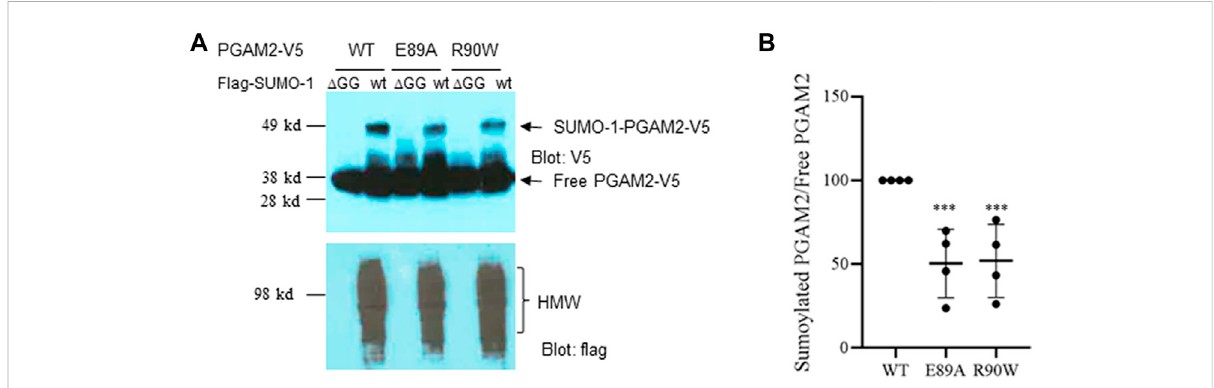
FIGURE 8 PGAM2 withmissensemutations linked with human disease exhibit reduced sumoylation.A Ni-NTApulldownexperiments wereperformed